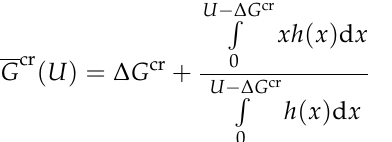
Figure 4. Deviatoric transformation plasticity factor T and its cumulative value of the amount of transformation f α (cid:48)